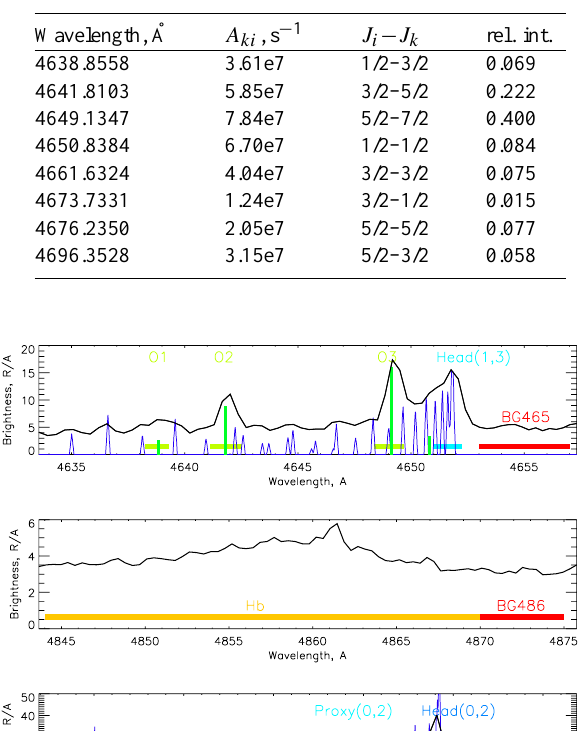
first negative 2